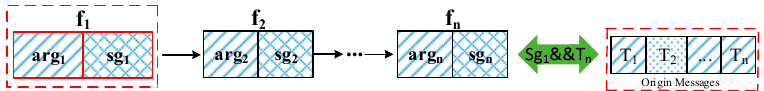
Figure 7. Token location in the second category.